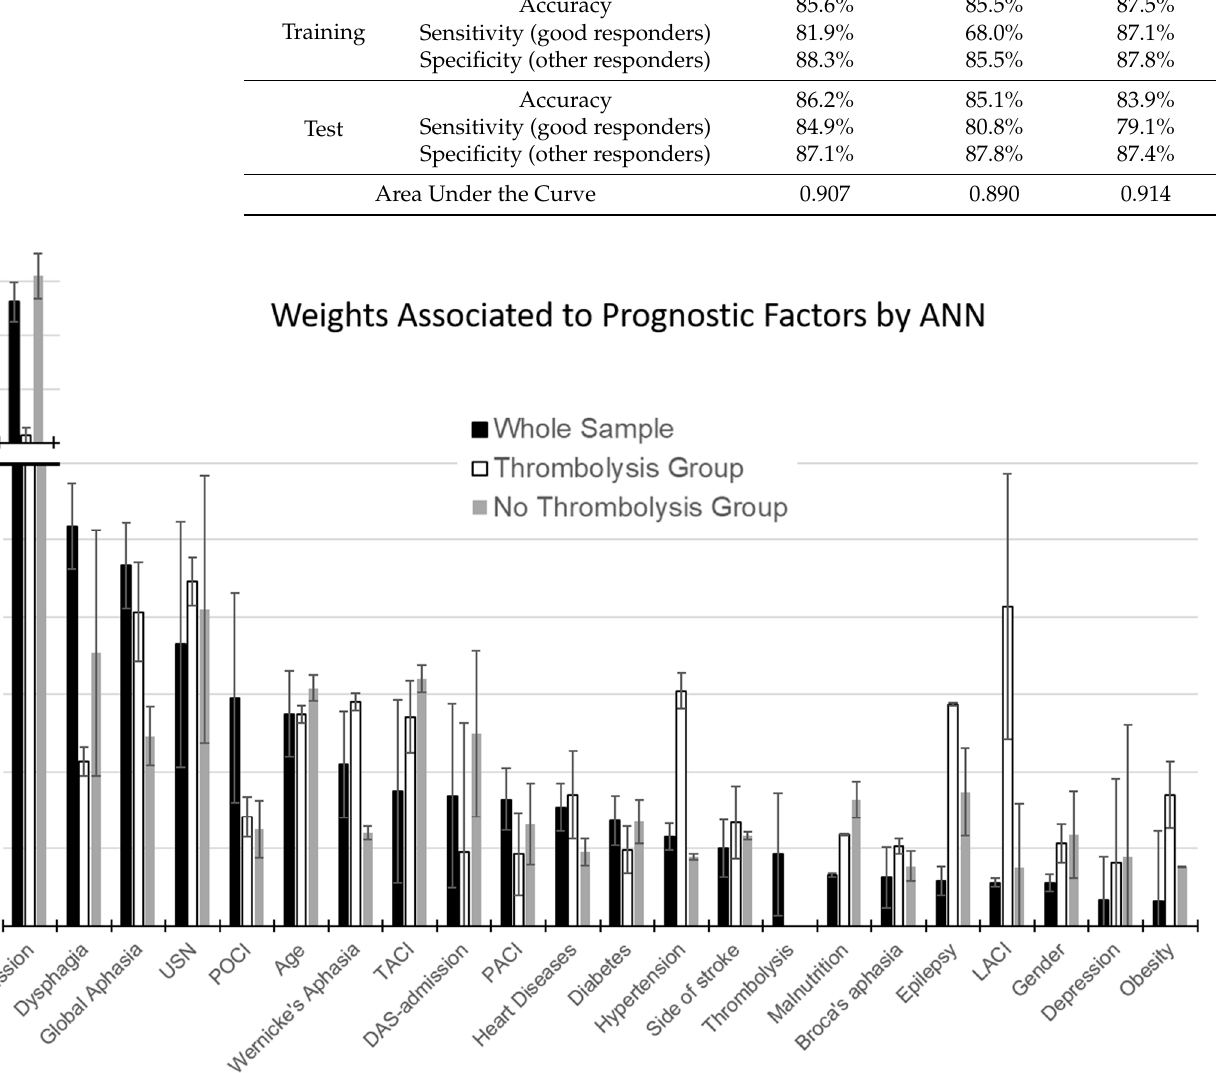
Figure 1. Percentage weights associated by Artificial Neural Network with the factors accounting for the predicted outcome (error bars represent the standard errors). Black bars refer to the whole sample of patients, white bars to those treated with thrombolysis (TG), and grey bars to patients not treated with thrombolysis (NTG).